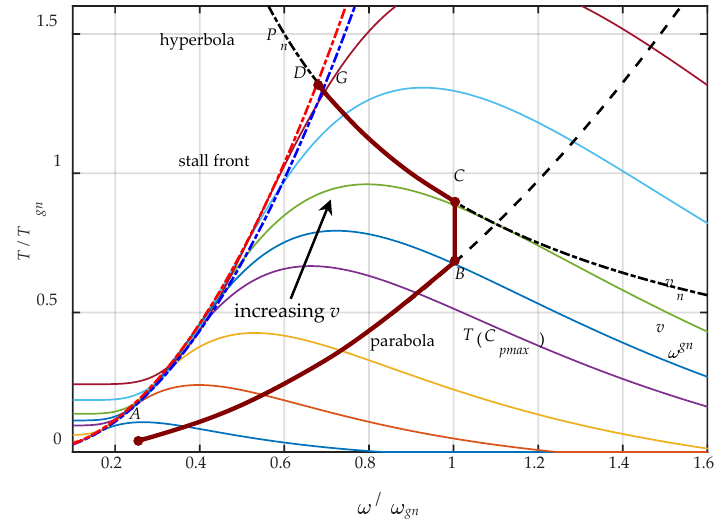
Figure 5. Trajectory drawn by operating points of a VSFP WT on the angular velocity–torque plane ω – T for the captured power and the rotational speed control strategy presented in Figures 4 and 5.